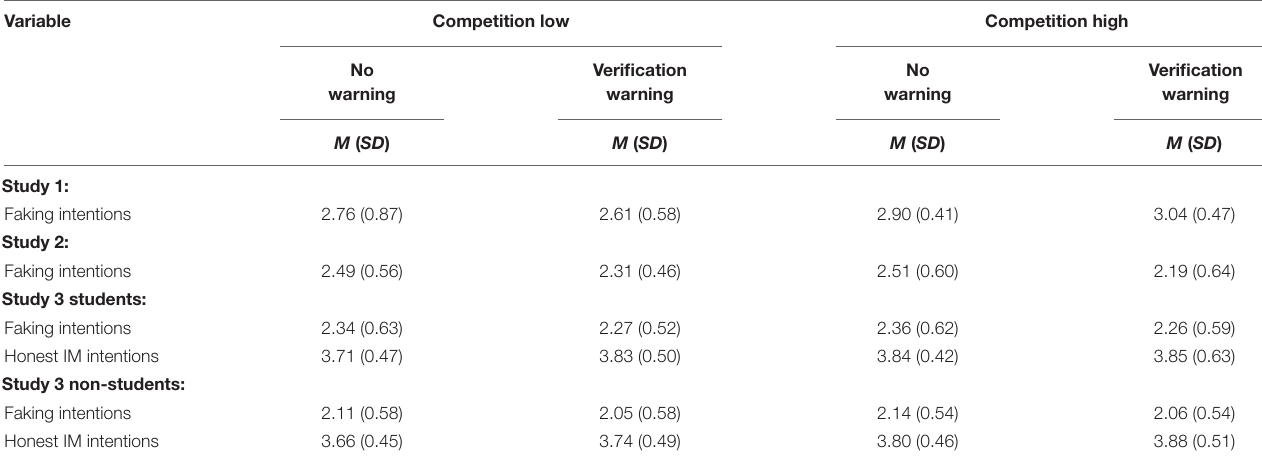
TABLE 2 | Means and standard deviations for the dependent variable faking intentions in the different experimental groups in Studies 1, 2, and 3 and for honest IM intentions in Study 3.